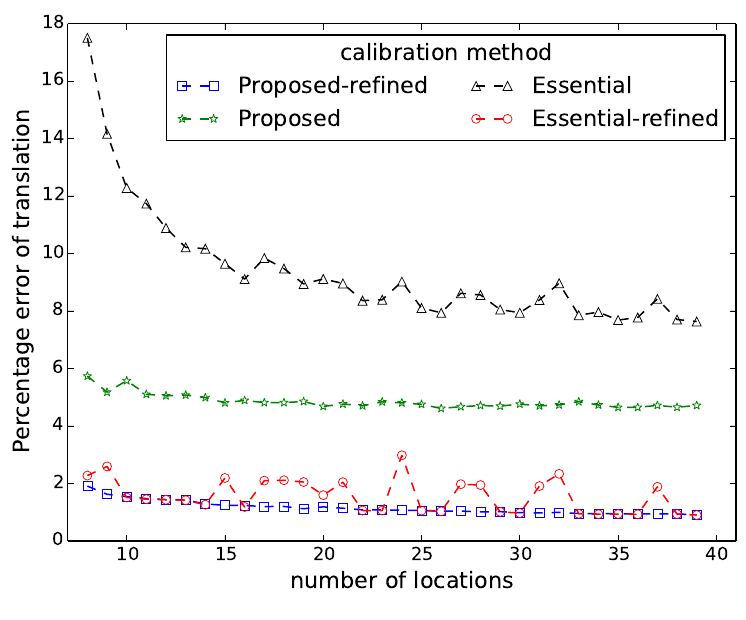
Figure 9. Relative translation error comparison between our method (proposed) and the method of Hödlmoser et al. [17] (essential) using different numbers of locations. Each location yields two calibration samples (head and